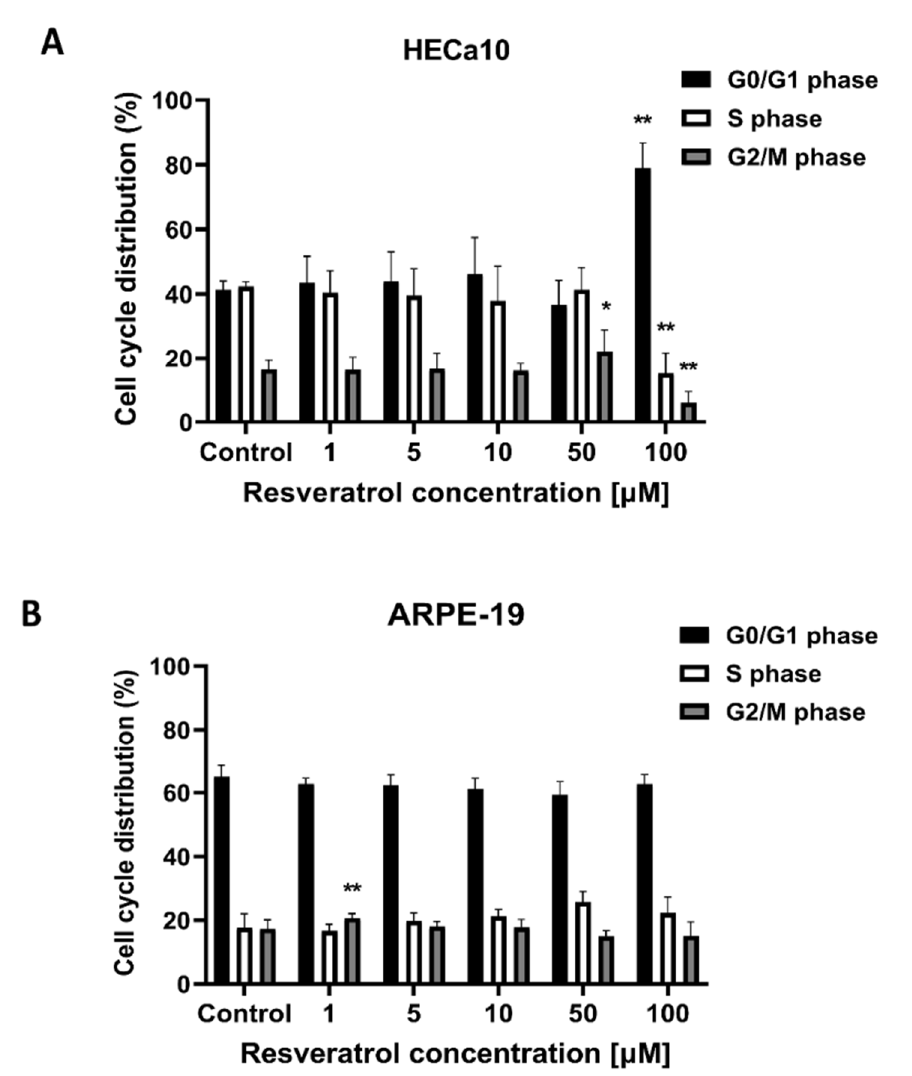
Figure 4. Effect of different RSV concentrations on the cell cycle of ( A ) HECa10 cells and ( B ) ARPE-19 cells. Cell were incubated for 24 h with RSV (1, 5, 10, 50, 100 µ M). Control cells were cultured with 0.1% DMSO and without RSV. Analysis of the cell cycle was performed using flow cytometry (FACS Calibur, BD) and calculated using ModFit LT. The results are presented as mean ± SD in at least of three experiments with * p < 0.05, ** p < 0.01 compared to the control.